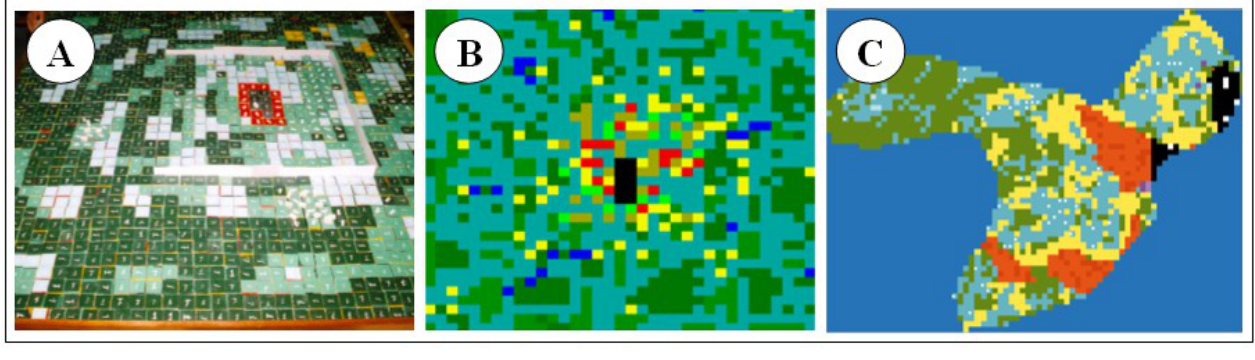
Fig. 5. The different environment grids used in the participatory simulation: (A) abstract landscape of the game board, (B) abstract landscape of the agent-based model (ABM) corresponding to the composition of the village landscape, (C) realistic landscape uploaded in the ABM from the village GIS. The colors show the different land uses of each 1000 m 2 cell: dark green = dense forest, green = open forest, light green = shrub/fallows, dark blue = tree plantation, yellow = upland crops, red = paddy field, black = residential